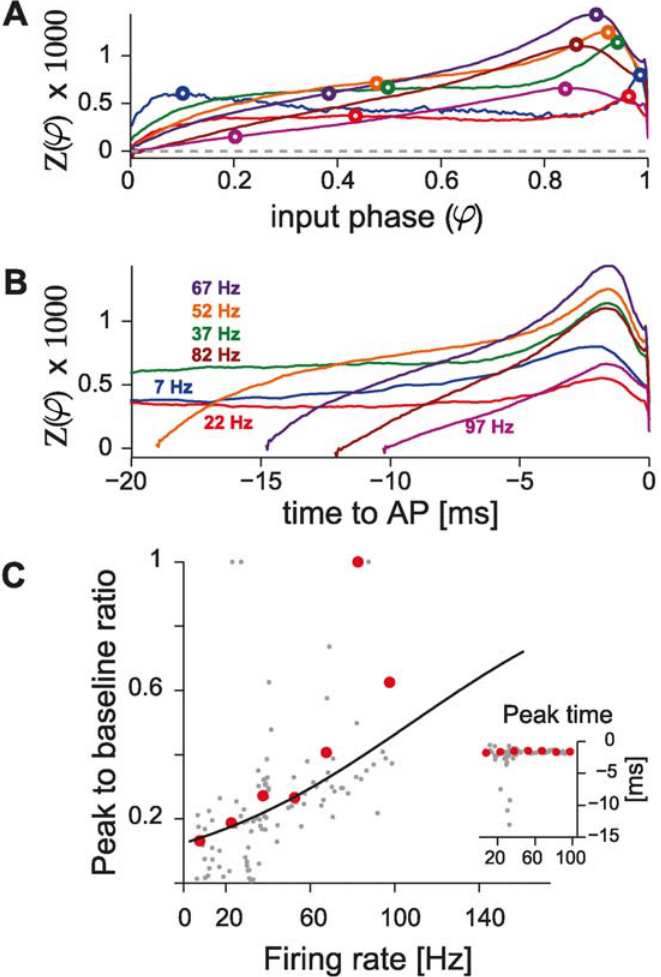
Fig 5. Population summary using the WSTA (indirect) method. (A) Population summary obtained over distinct firing rates, obtained averaging across 95 PRCs, binned for similar firing rates and obtained from 16 PCs. As in Fig. 3D, the average PRCs are equivalently represented (B) as a function of time (i.e., τ = ( φ − 1) (cid:1) h ISI i ) for the 20 ms preceding the perturbed AP. (C) The peak-to-baseline ratio once more confirms the observations obtained in Figs. 2, 4 and 3 (individual cells, n = 16: gray markers; averages from A: red markers). The black curve represents the function (1 + e − ( F − a )/ b ) − 1 , with best-fit parameters a = 105.6, b = 55.8 optimized over the set of individual PCs. The inset displays the location of the PRC peak, relative to the time of the AP following the stimulus (i.e., τ peak = ( φ peak − 1) (cid:1) h ISI i ), for the same cells, as in Figs. 2B and 3C.